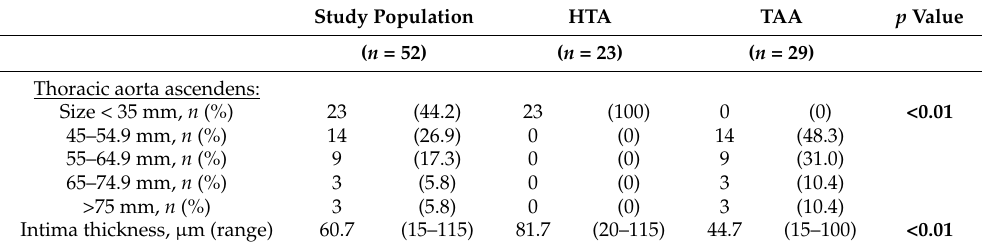
Table 3. Aneurysm size characteristics of the study